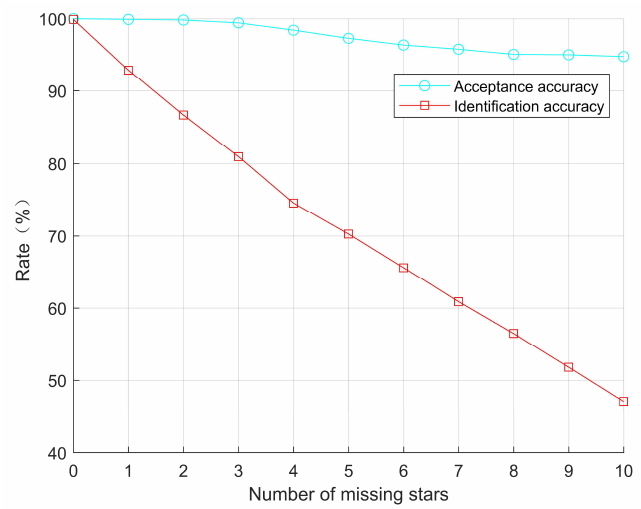
Figure 19. Acceptance accuracy and identification accuracy sensitivity to missing stars.